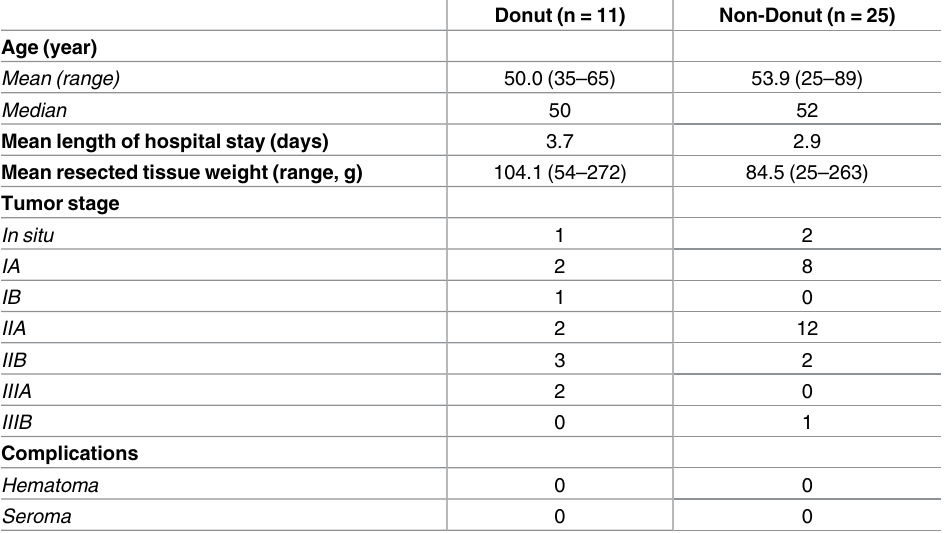
Table 1. Characteristics of the patients who underwent matrix rotation